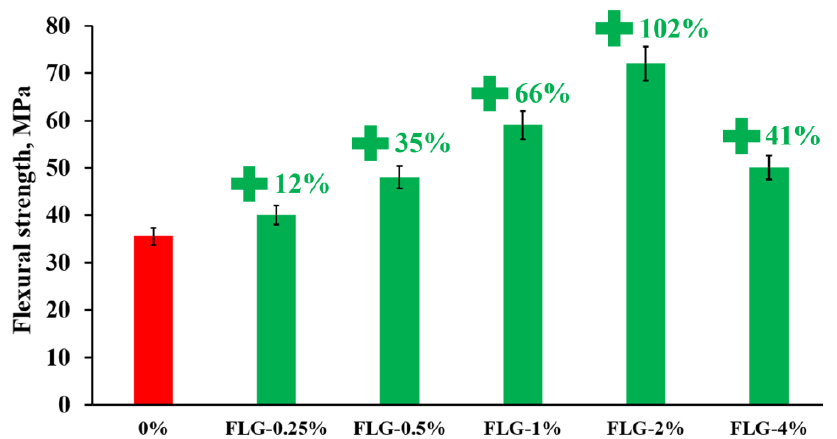
Figure 7. Flexural strength of samples depending on the concentration of FLG.